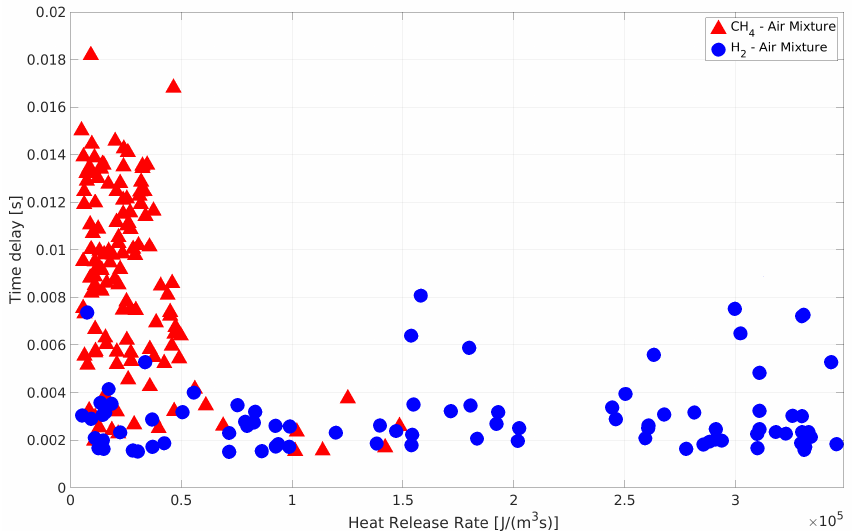
Figure 21. Comparison of the time delay versus the heat release rate for the methane–air and hydrogen–air